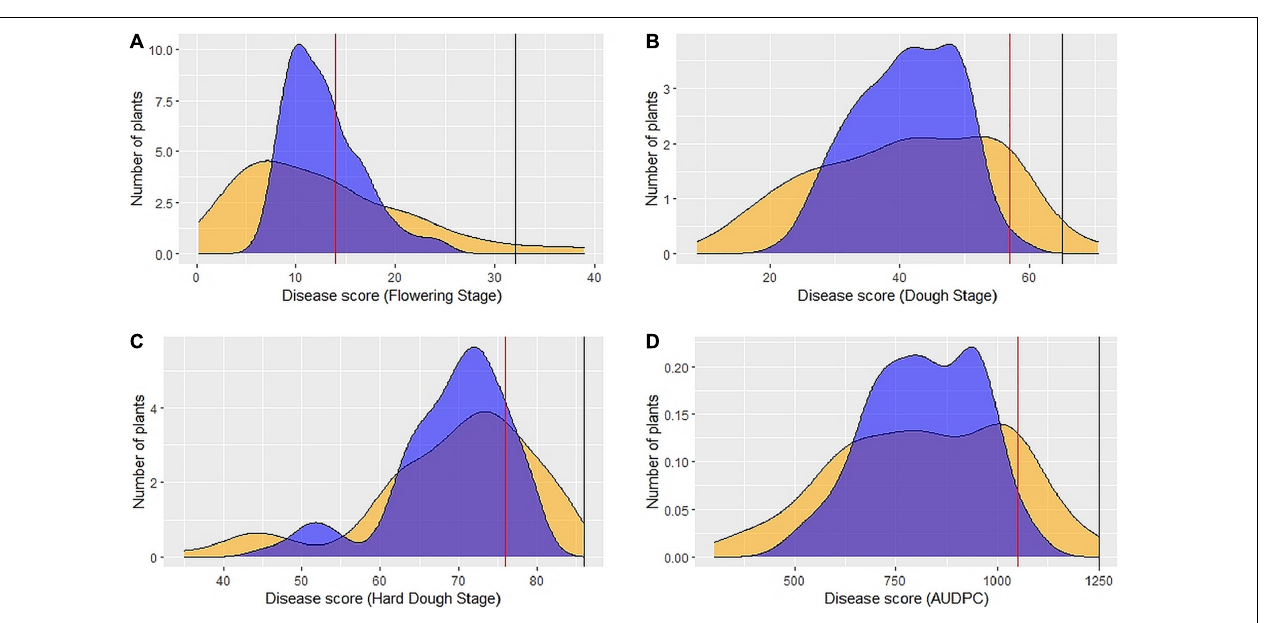
FIGURE 2 | Distribution of 89 DSBILs for spot blotch severity based on BLUEs (yellow color) and BLUPs (blue color) for disease score at flowering stage (A) , dough stage (B) , hard dough stage (C) and AUDPC (D) . The vertical red line indicates disease score of recurrent parent PDW274, the vertical black line indicates disease score of susceptible check Raj4015, and the disease score or A. speltoides was 00 across the